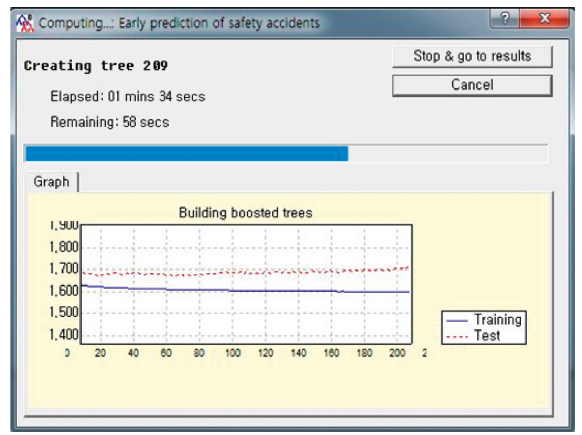
Figure 3: Training process of the SGB model.